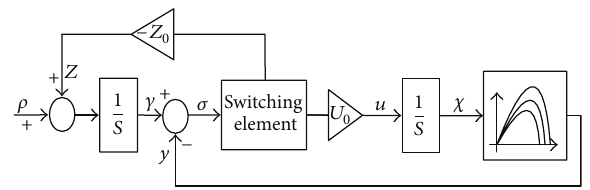
Figure 3: Block diagram of proposed SMESC